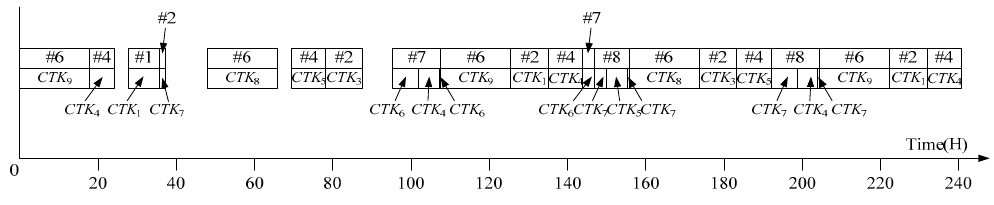
Figure 11. Detailed schedule of oil transportation from storage tanks to charging tanks.